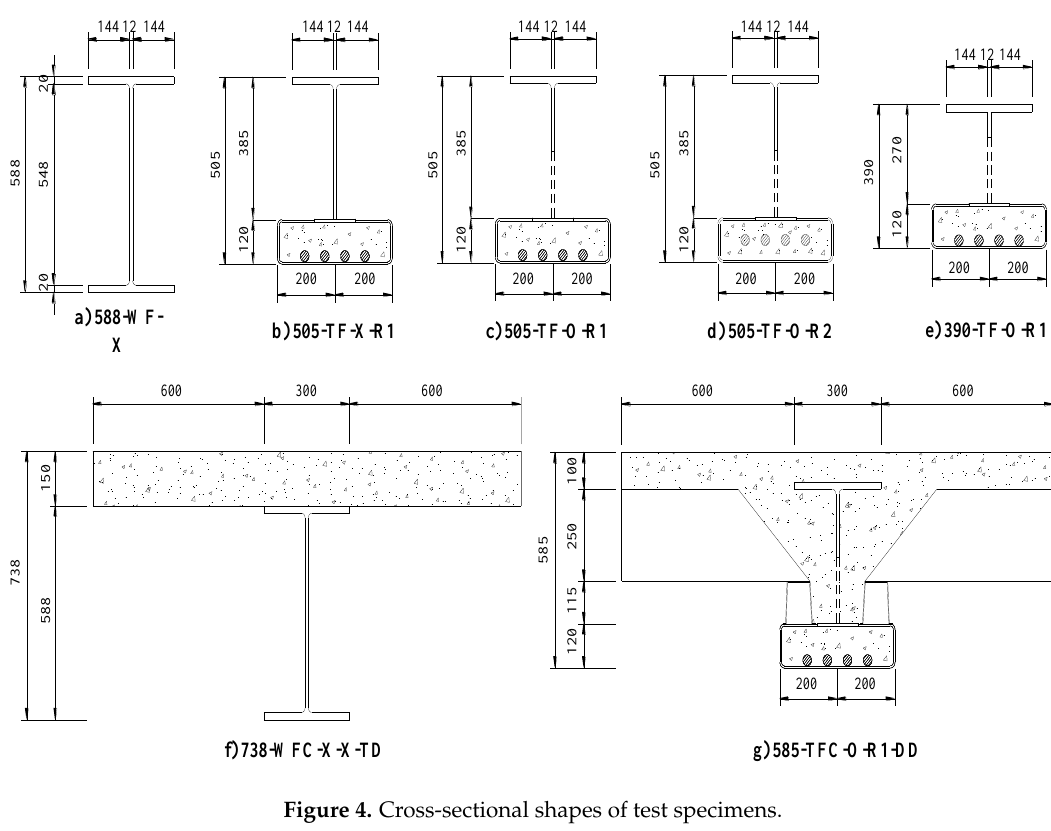
Figure 4. Cross-sectional shapes of test specimens.